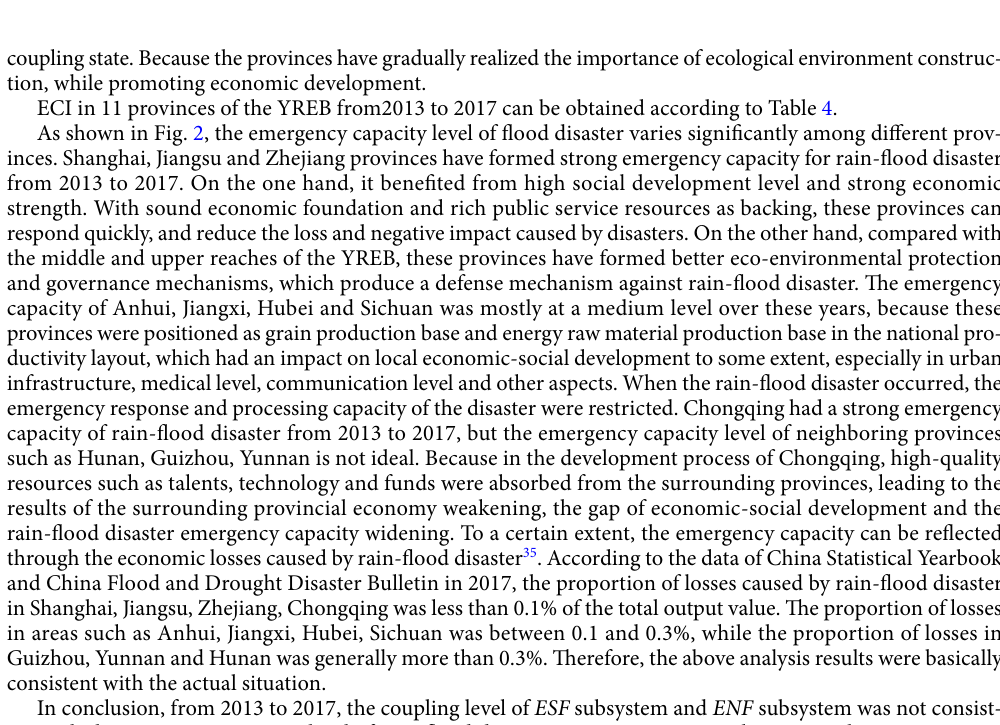
Table 4. Provincial index calculation results. ES the development index of economic-social factors, EN the development index of economic-social factors, CI the coupling